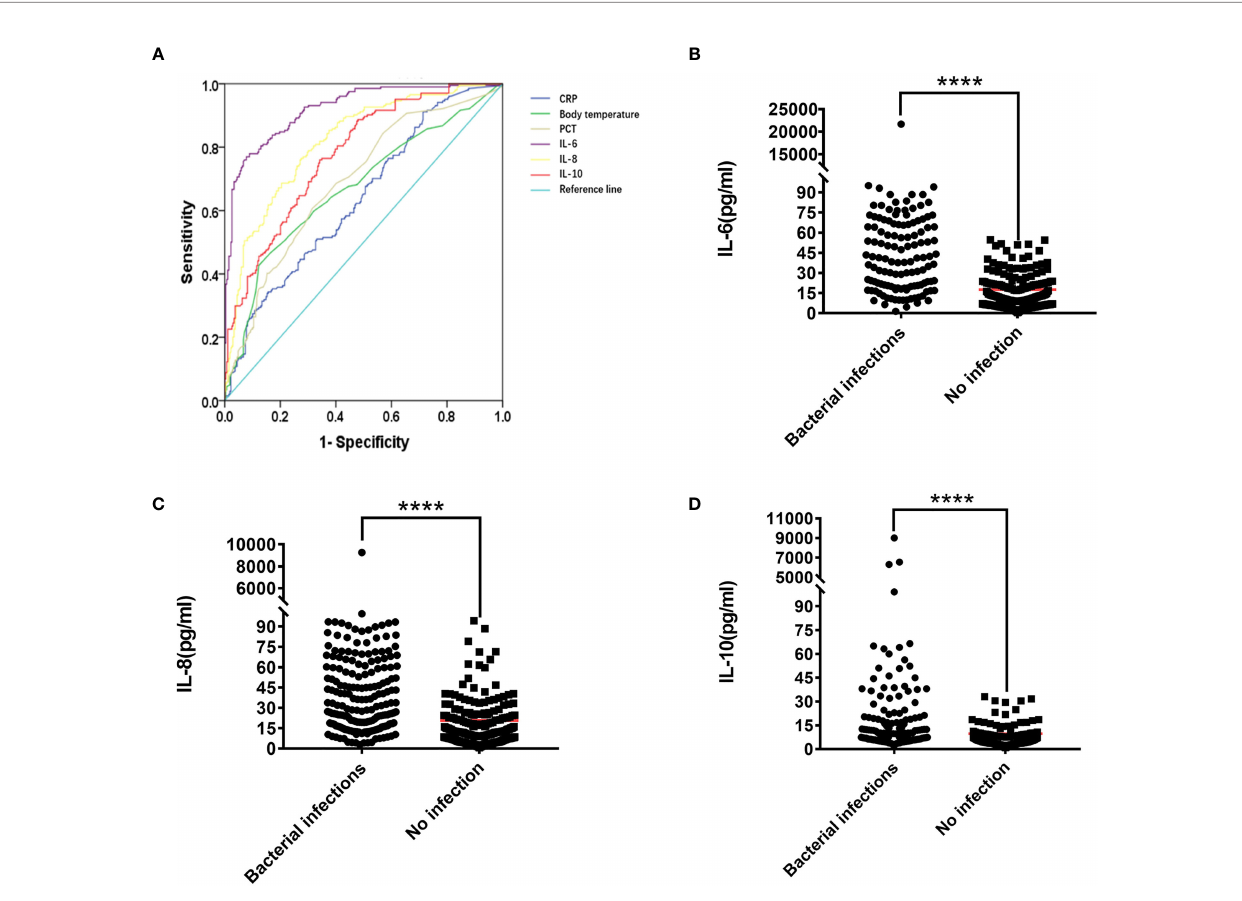
FIGURE 2 | (A) ROC curve of IL-6, IL-8, IL-10, PCT, CRP, Temperature. The Mann-Whitney U test was used to test the difference in expression between patients with lung bacterial infection and those without bacterial infection (B) IL-6, (C) IL-8. (D) IL-10. ****P <